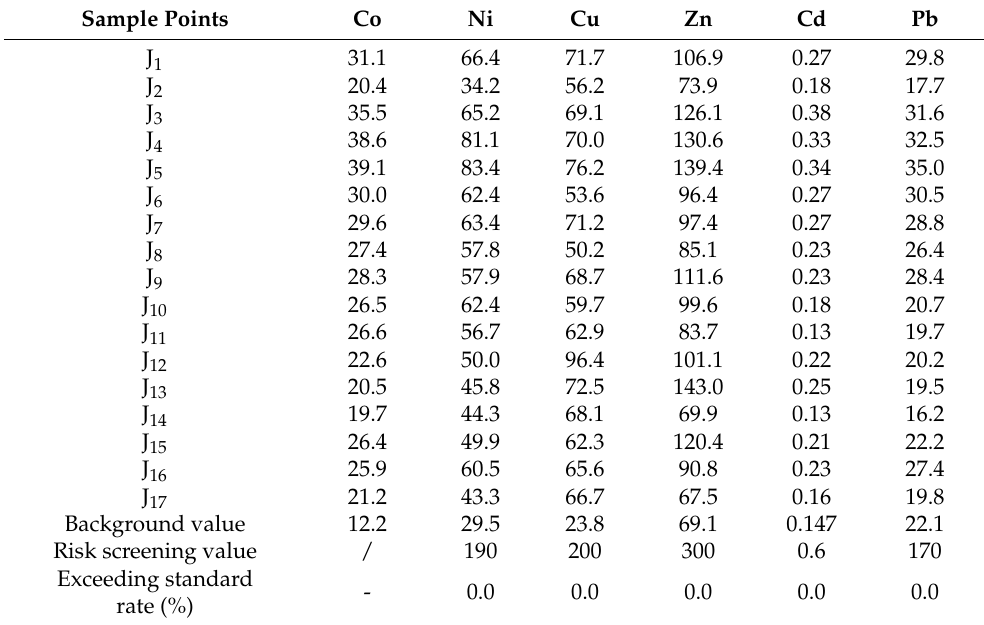
Table 2. Heavy metal concentrations in soils from winter jujube farms of Binzhou City (mg/kg). Sample Points